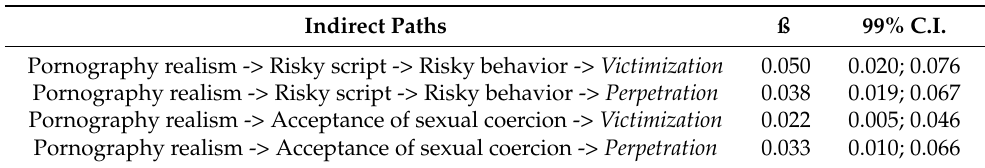
Table 3. Significant indirect paths in the model based on standardized bias-corrected bootstrapped confidence intervals.